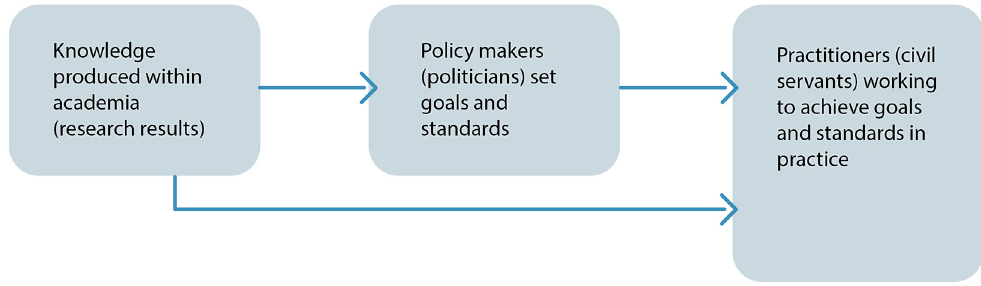
Figure 1. Ideal model of how research results are expected to be applied in policy making and practice in the Swedish political and administrative context.